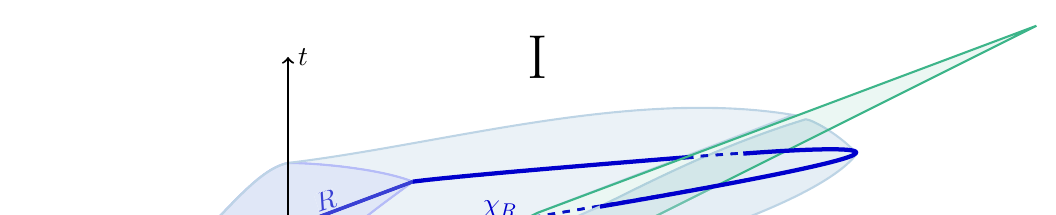
Figure 6 . The critical length c is smaller than the horizon length c cr which p ( d ) = 1 + 2 / ( d 1). min − −